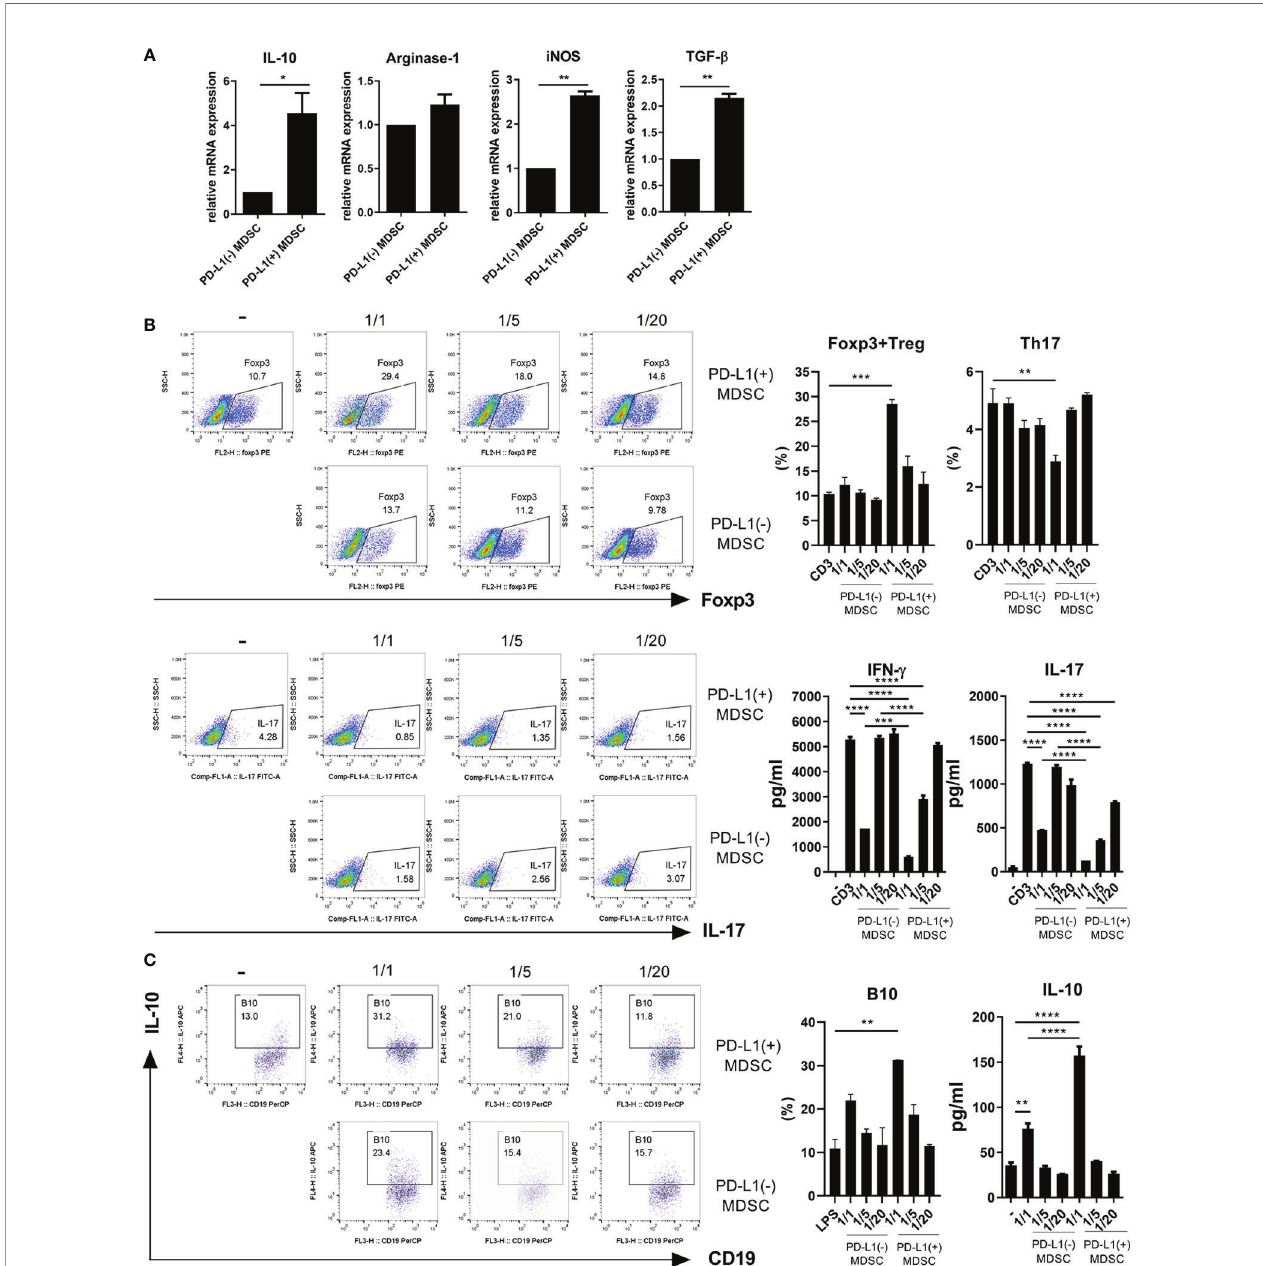
FIGURE 1 | PD-L1 expressing MDSCs have stronger in vitro immunoregulatory activity in mice. (A) MDSCs were obtained from C57BL/6 mice as described in Materials and Methods section. MDSCs sorted into PD-L1+ and PD-L1 − sub-populations using a cell sorter. (A) The mRNA levels of IL-10, arginase-1, iNOS and TGF- b in PD-L1 positive or negative MDSCs were determined using real-time PCR. (B) CD4+T cells (5 × 10 5 ) were cultured with PD-L1 positive or negative MDSCs in the presence of anti-CD3 (0.5 m /ml). After 3 days, cells were analyzed for Treg (CD4+CD25+Foxp3+) and Th17 (CD4+IL-17+) cells. The representative fl ow cytometric plot is shown. The percentage of each cell population among CD4+ T cells are shown in the right upper panel. The concentrations of IL-17 and IFN- g in culture supernatant were measured by ELISA. (C) Splenocytes (5 × 10 5 ) were cultured with PD-L1 positive or negative MDSCs in the presence of LPS (100 ng/ml). After 3 days, cells were analyzed for IL-10 producing B10 cells (CD19+CD1d+CD5+ cells) by fl ow cytometry. The percentage of each cell population are shown in the right panel. The concentrations of IL-10 in supernatant were measured by ELISA. Data are expressed as the mean ± SEM. Data are representative of three independent experiments (* P < 0.05, ** P < 0.01, *** P < 0.001, **** P <